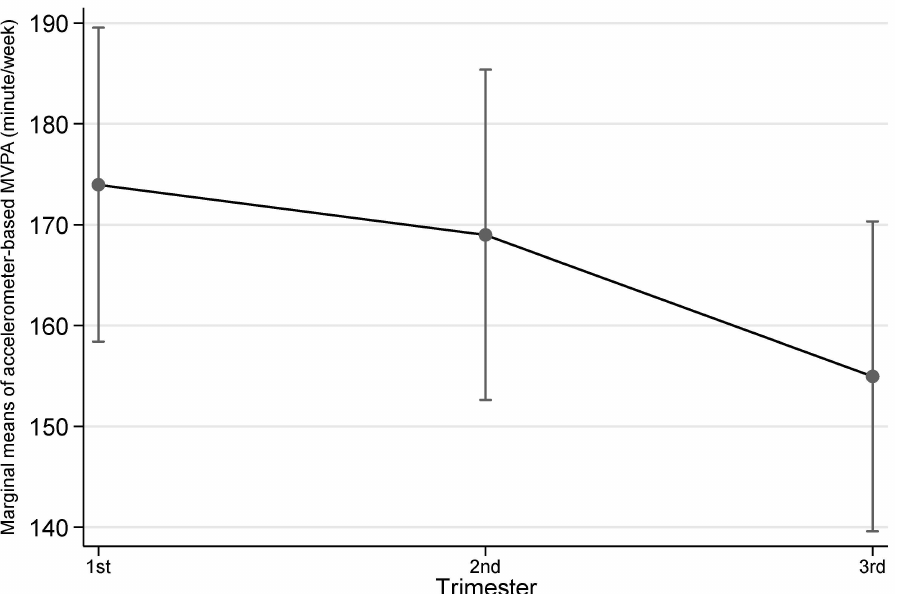
Figure 1. Accelerometer-based moderate-to-vigorous physical activity (MVPA) by trimester. Notes: The error bars represent 95% confidence intervals of the corresponding point estimates.